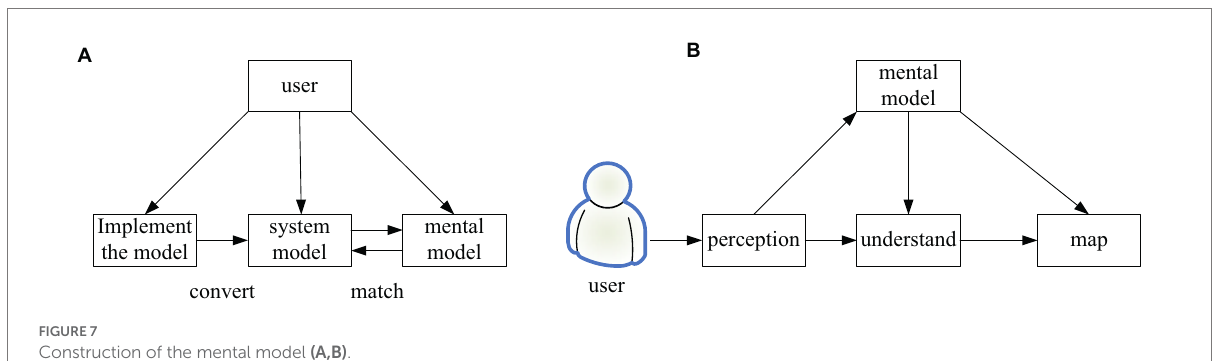
FIGURE 6 Relationship between the three models.